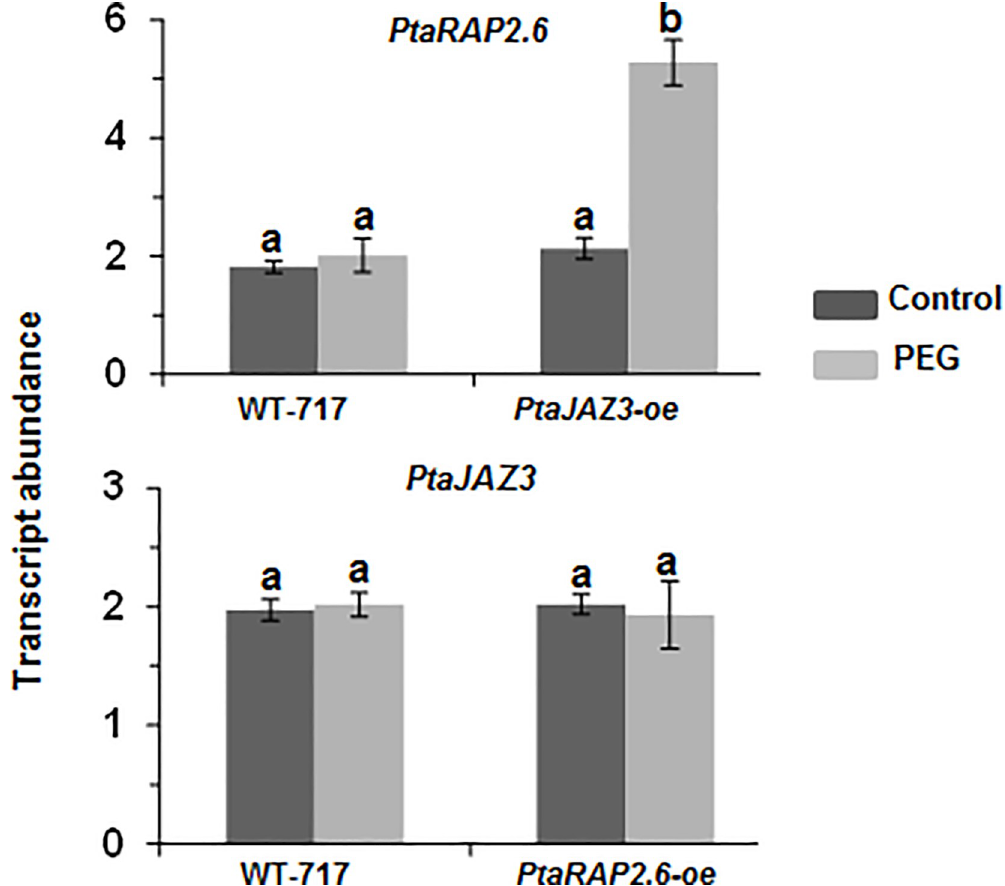
Fig 7. PtaRAP2 . 6 expression was increased in response to PEG treatment in PtaJAZ3 overexpressing lines. Expression of PtaJAZ3 (top) and PtaRAP2 . 6 (bottom) was analyzed in root samples of WT-717 and PtaRAP2 . 6- overexpression ( oe ) and PtaJAZ3-oe transgenic lines, respectively, growing in control and PEG liquid media. Two independent lines (4 replicates per line) were measured for calculating the value of each transgenic modification that is shown as mean ± standard error of mean (SEM) ( n = 2). Different letters represent those means that are statistically different ( P < 0.05) as determined by a one-way ANOVA followed by Tukey’s multiple range tests.